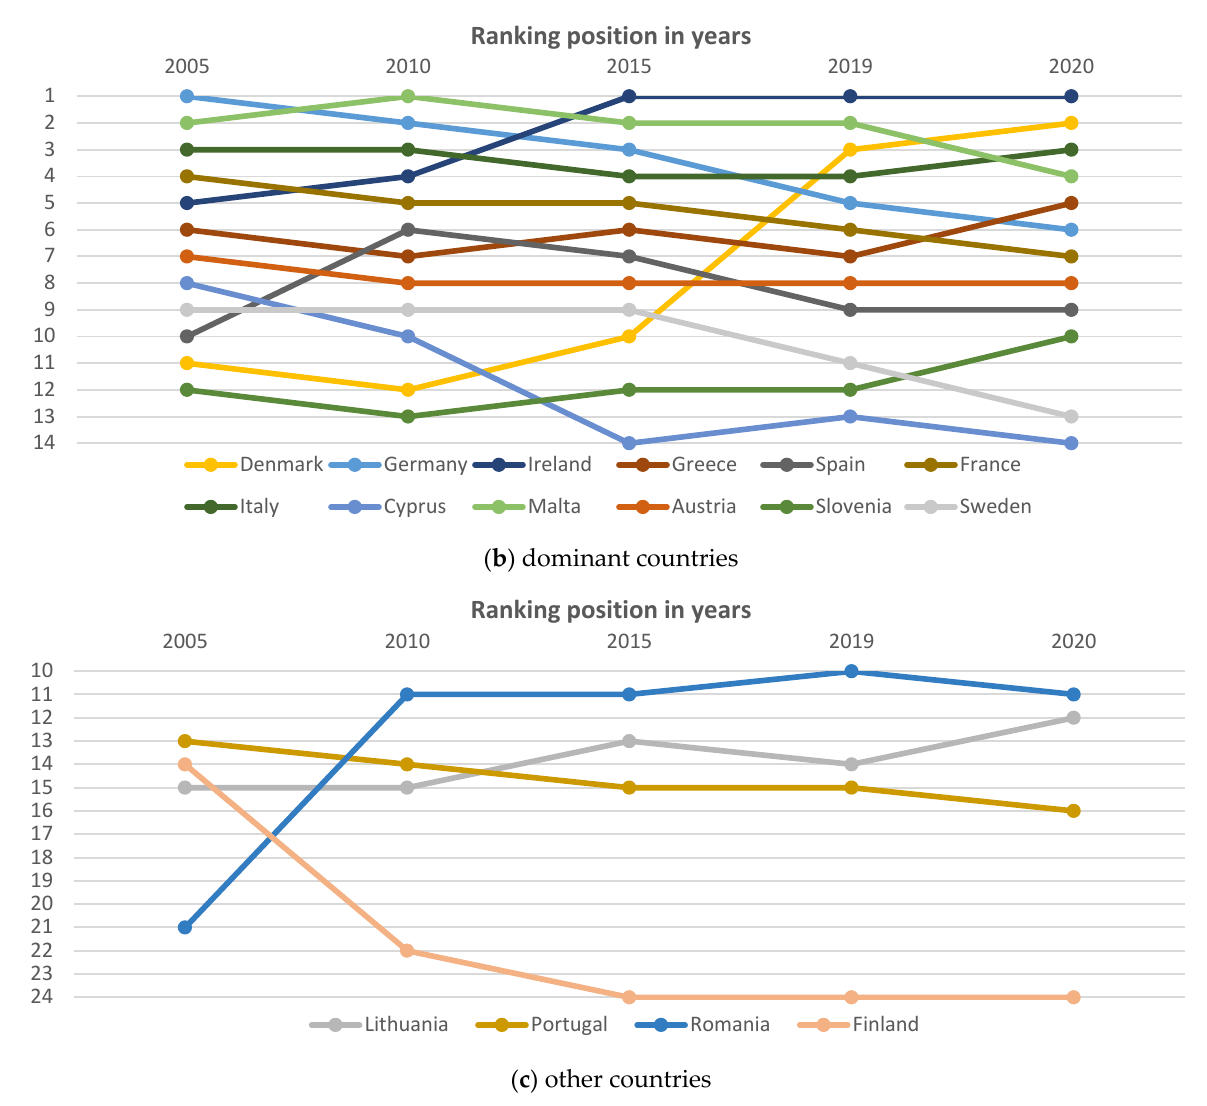
Figure 4. Positions achieved in the individual rankings for energy intensity. ( a ) dominated countries; ( b ) dominant countries; ( c ) other countries.